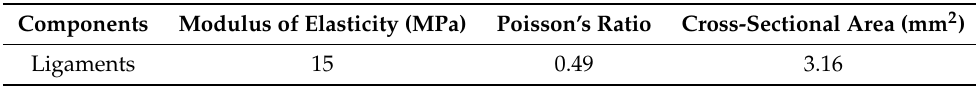
Table 4. Ligamentous tissue material parameters.